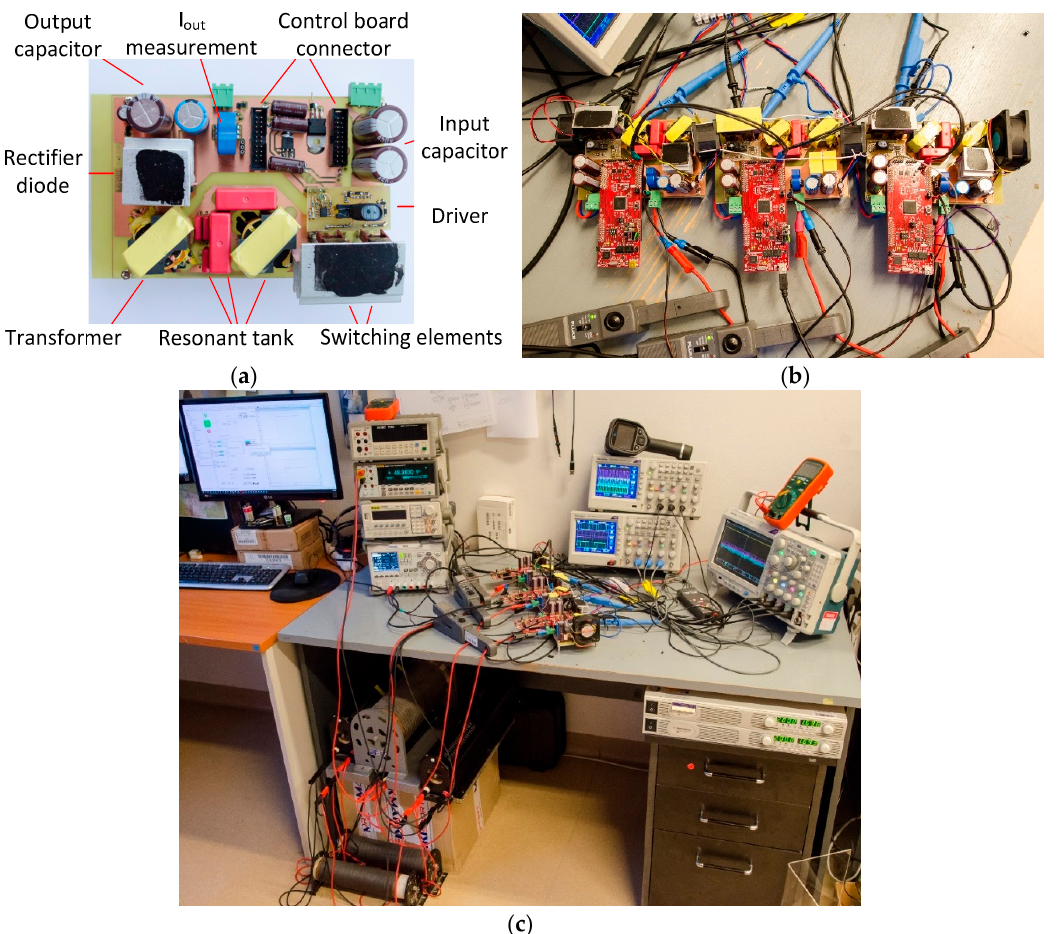
Figure 7. Physical prototype of proposed LCCT converter ( a ), and its modular concept ( b ), within experimental set-up ( c ) .